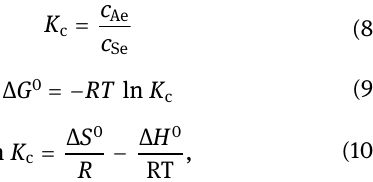
Figure 7: Langmuir isotherm plots for the adsorption of GPC on resin 001 × 7 at di ff erent temperatures.